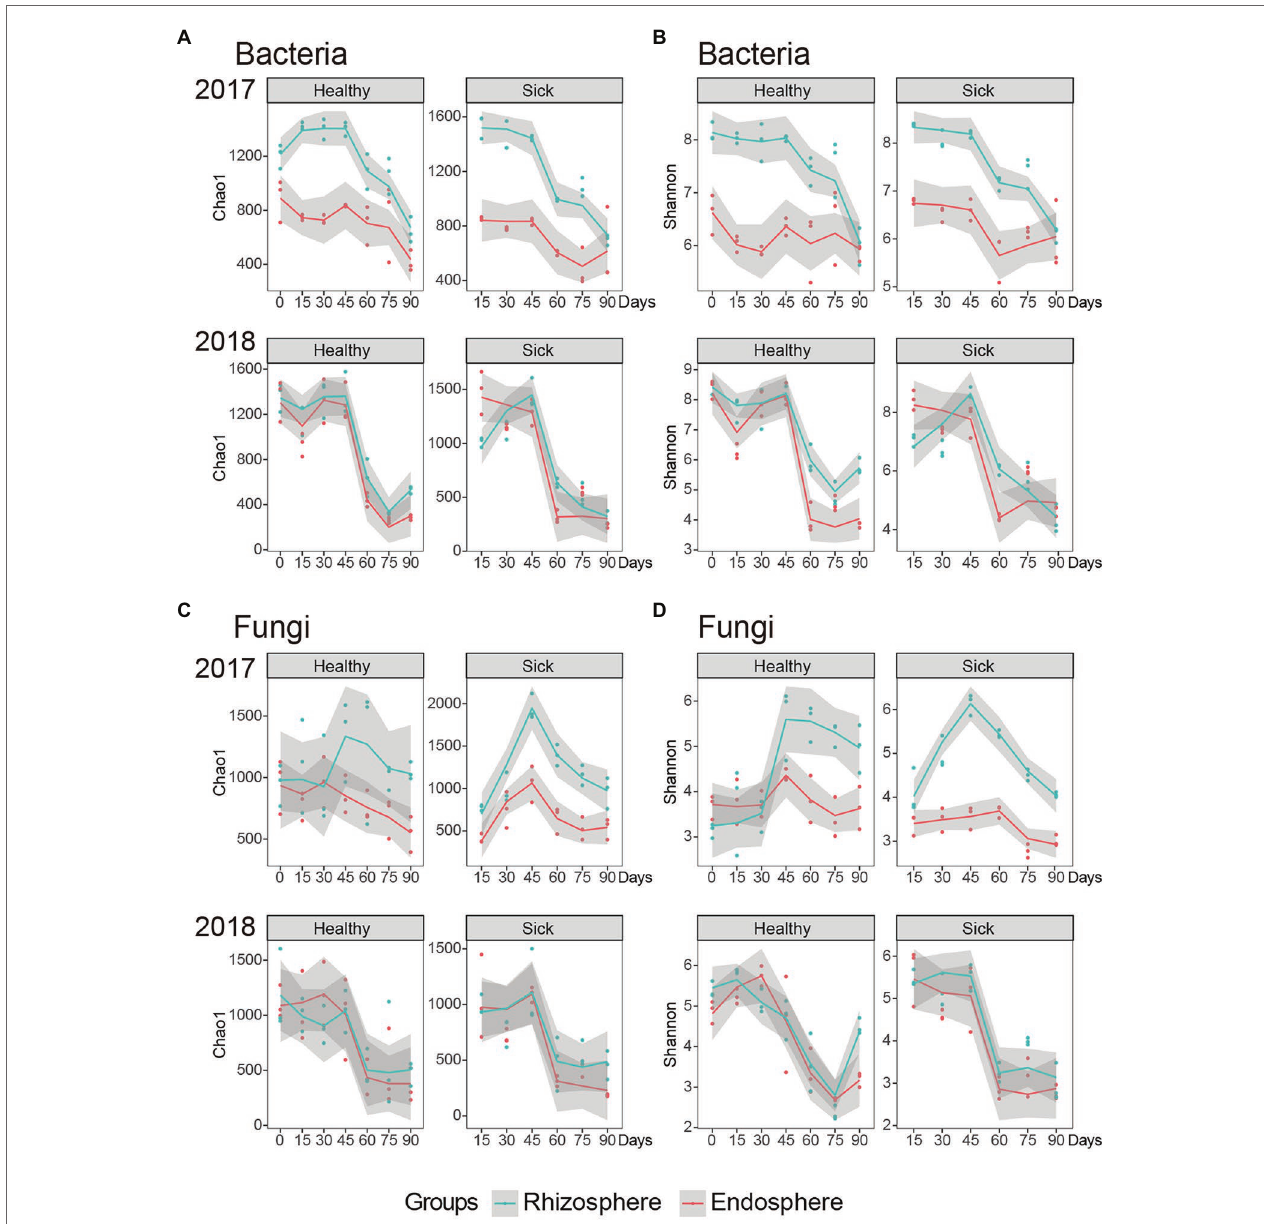
FIGURE 1 | Abundance and diversity of root microorganisms in RKN-infected and healthy tobacco. (A) The Chao1 index of rhizosphere and endophytic bacteria. (B) The Shannon index of rhizosphere and endophytic bacteria. (C) The Chao1 index of rhizosphere and endophytic fungi. (D) The Shannon index of rhizosphere and endophytic